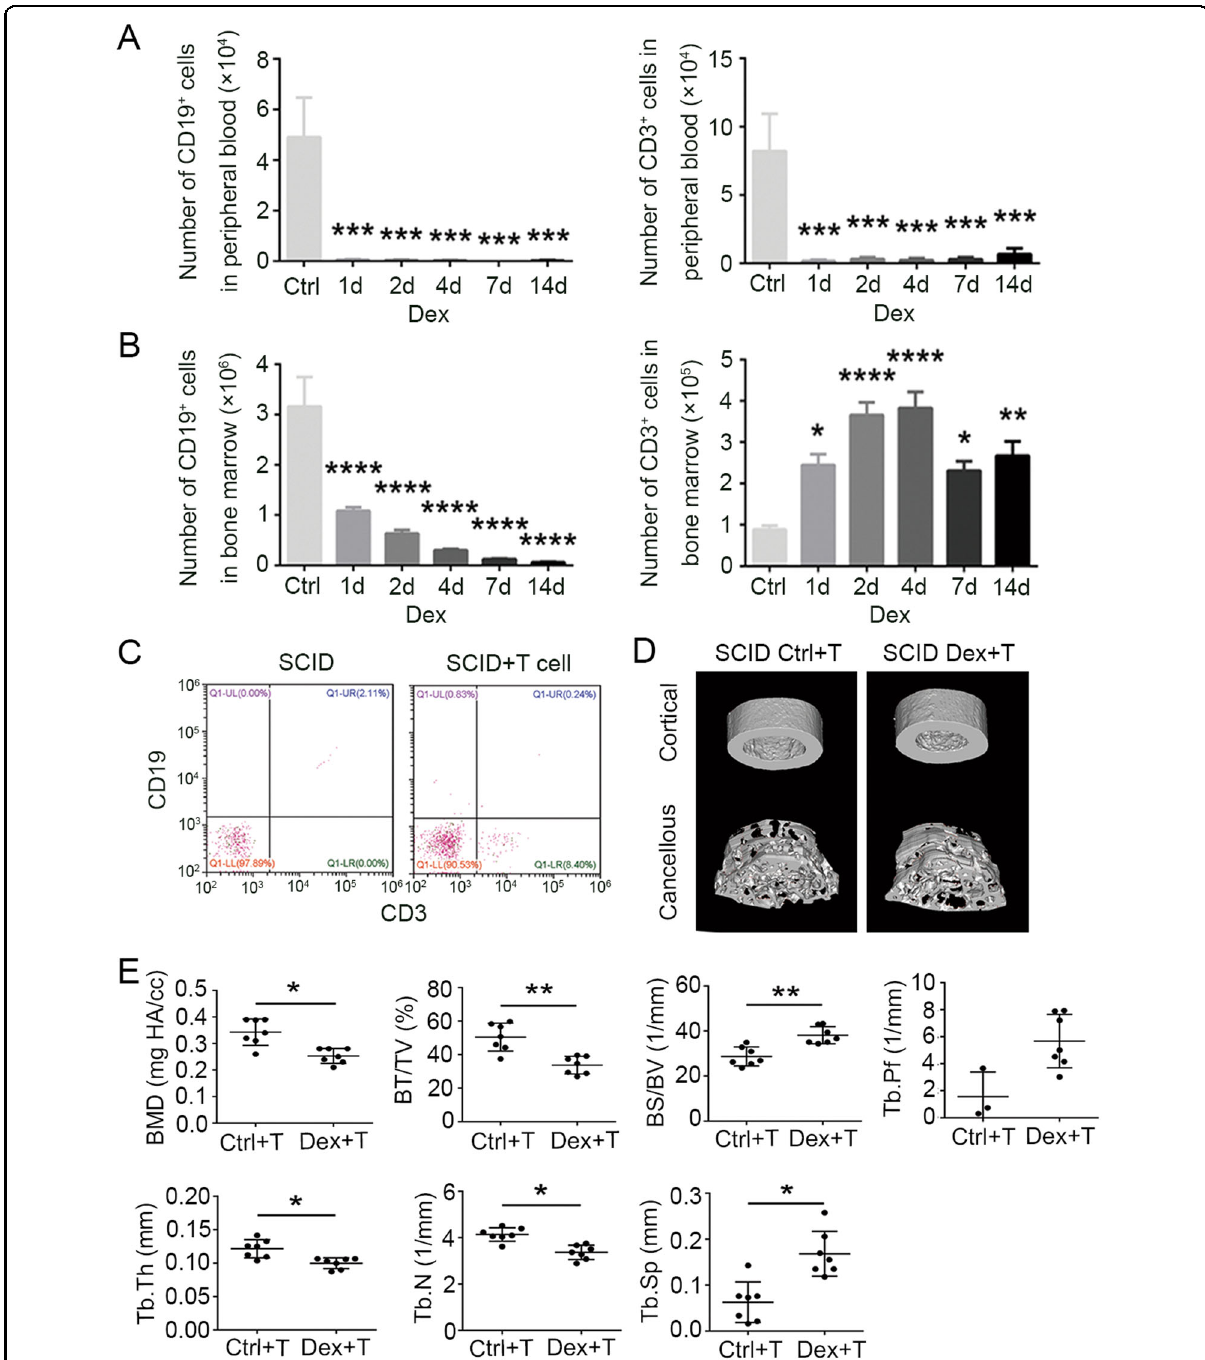
Fig. 3 Reconstitution of SCID mice by transplantation of T cells re-establishes dexamethasone-induced osteoporosis. Numbers of CD19 +